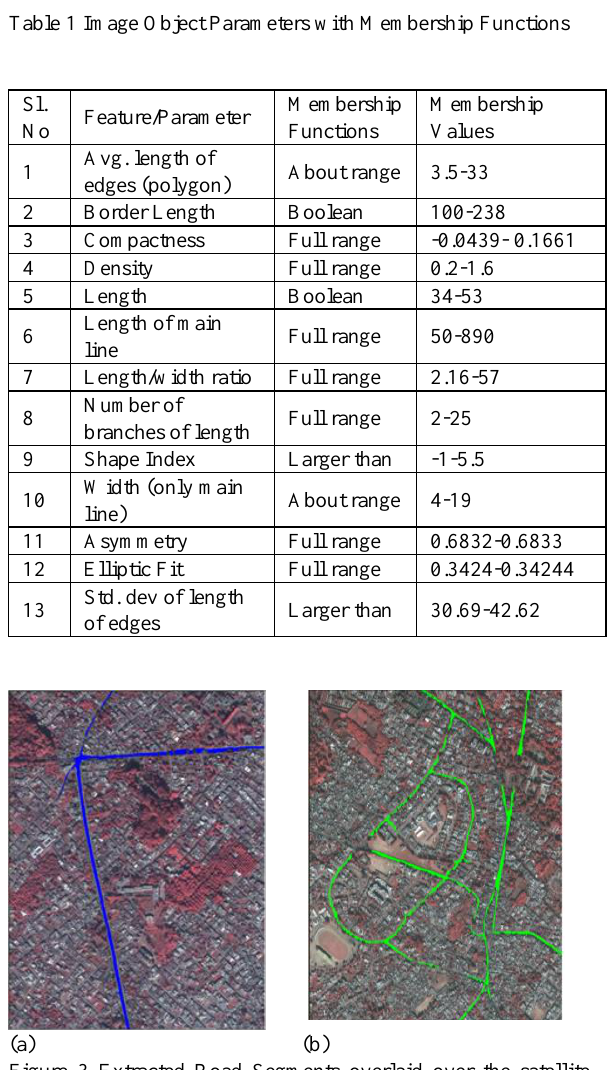
Figure 3 Extracted Road Segments overlaid over the satellite imagery